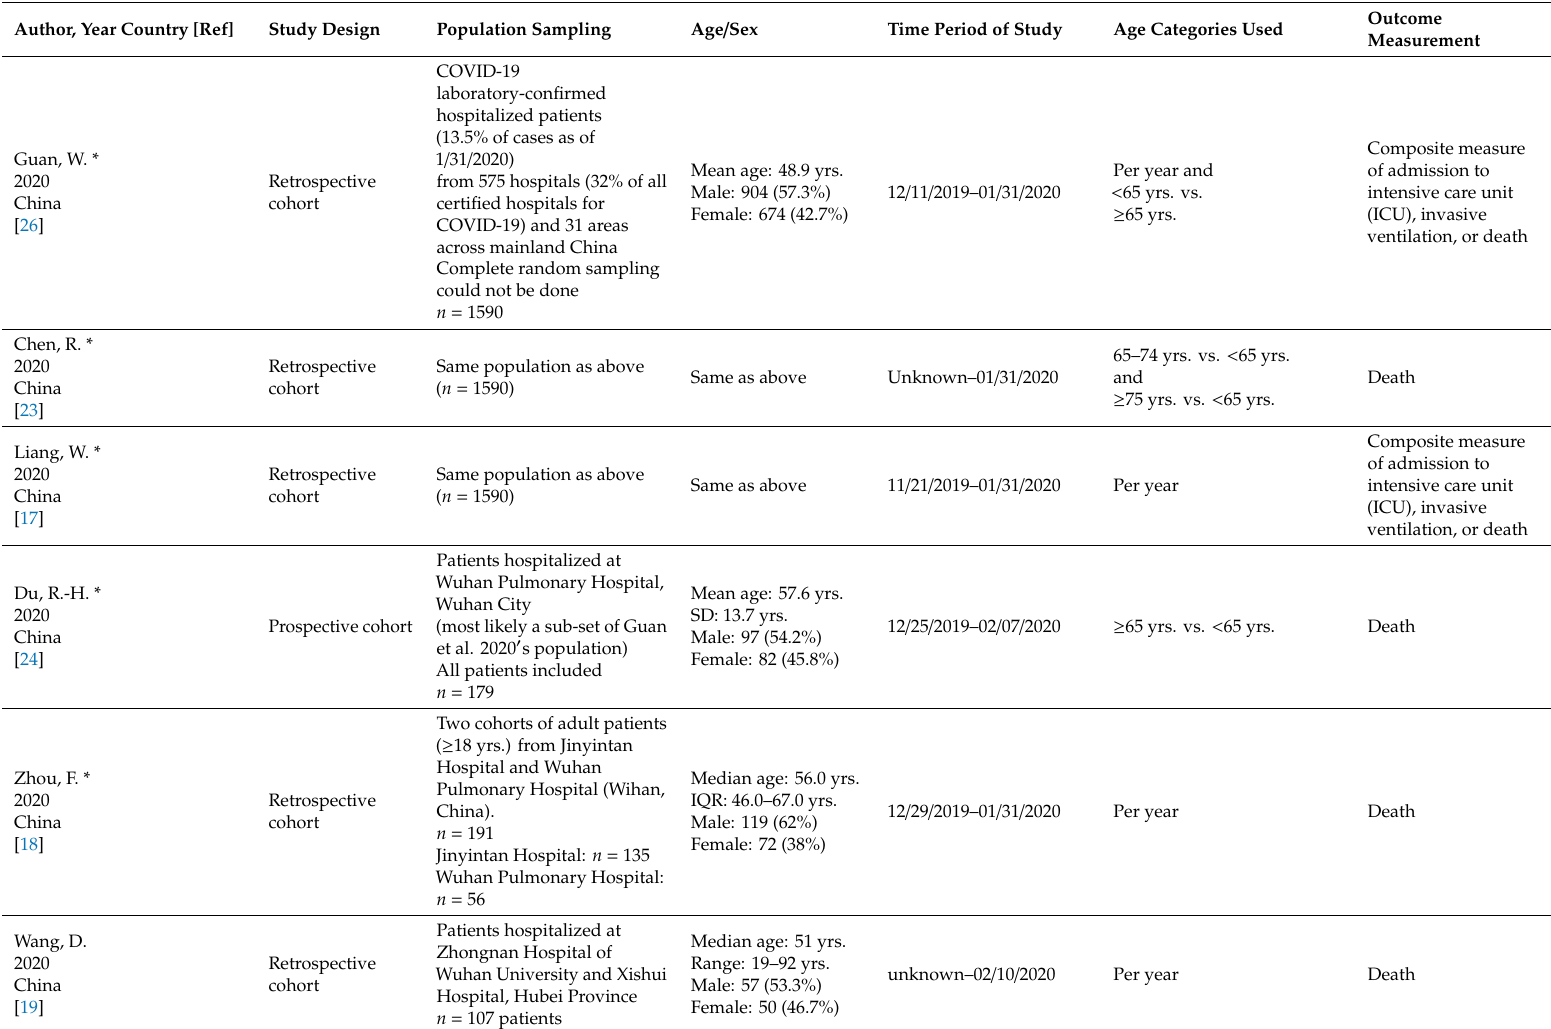
Table 2. Characteristics of the included